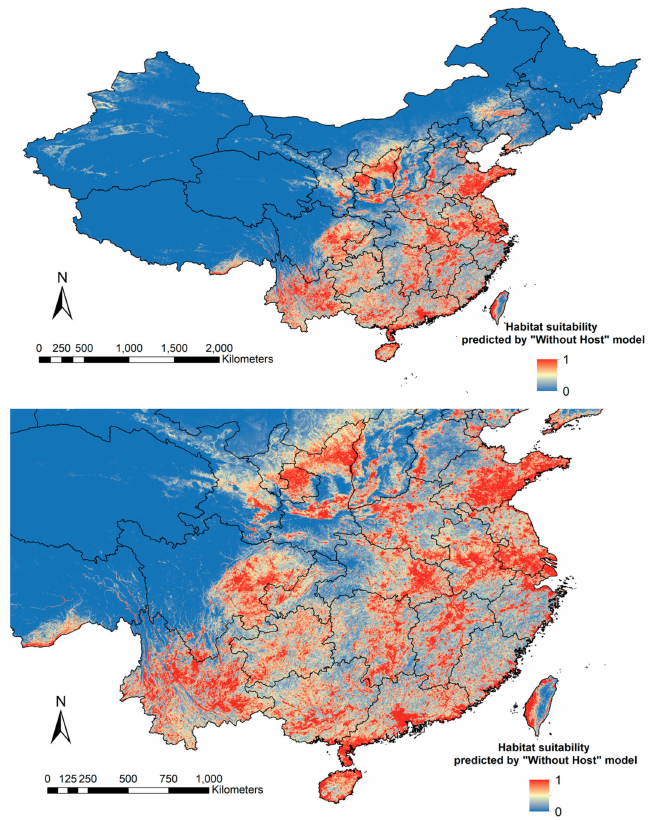
Figure 3. Distribution prediction map of Cx. tritaeniorhynchus based on the “Without Host” model. Prediction of habitat suitability of Cx. tritaeniorhynchus by using layers excluding human population density and pig density (the “Without Host” model, n = 12).